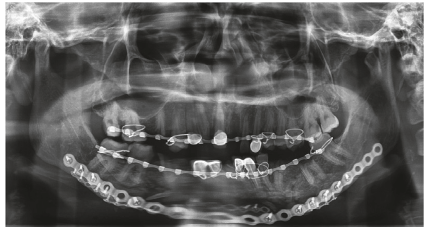
Figure 4: Postoperative panoramic showing good fracture re- duction and occlusion achieved.